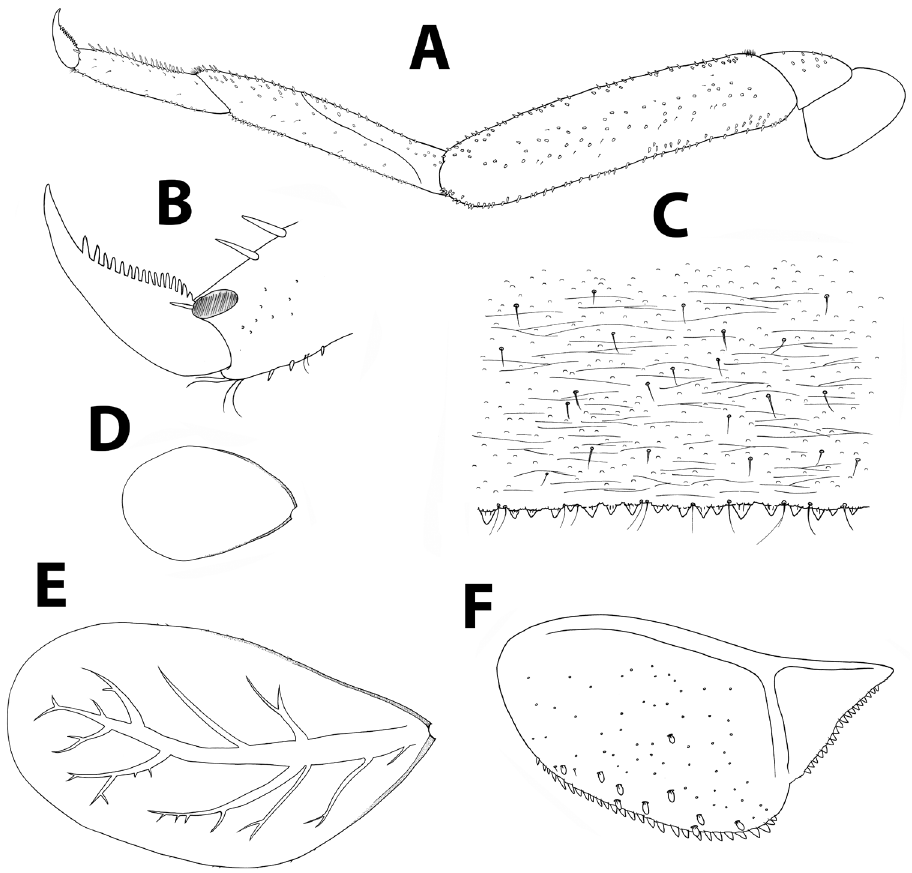
Figure 6. Baetis aureus sp. n., nymph. A foreleg B tarsal claw C abdominal tergum V, surface and distal margin D gill I E gill IV F paraproct